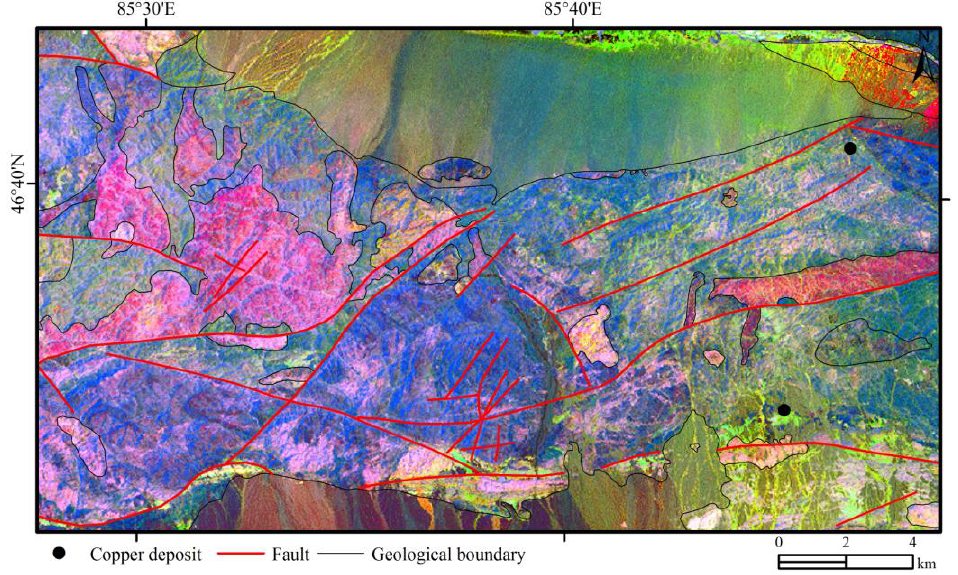
Figure 3. PCA1, PCA2 and PCA4 transformed to HSI space with I, H, and S in RGB image.